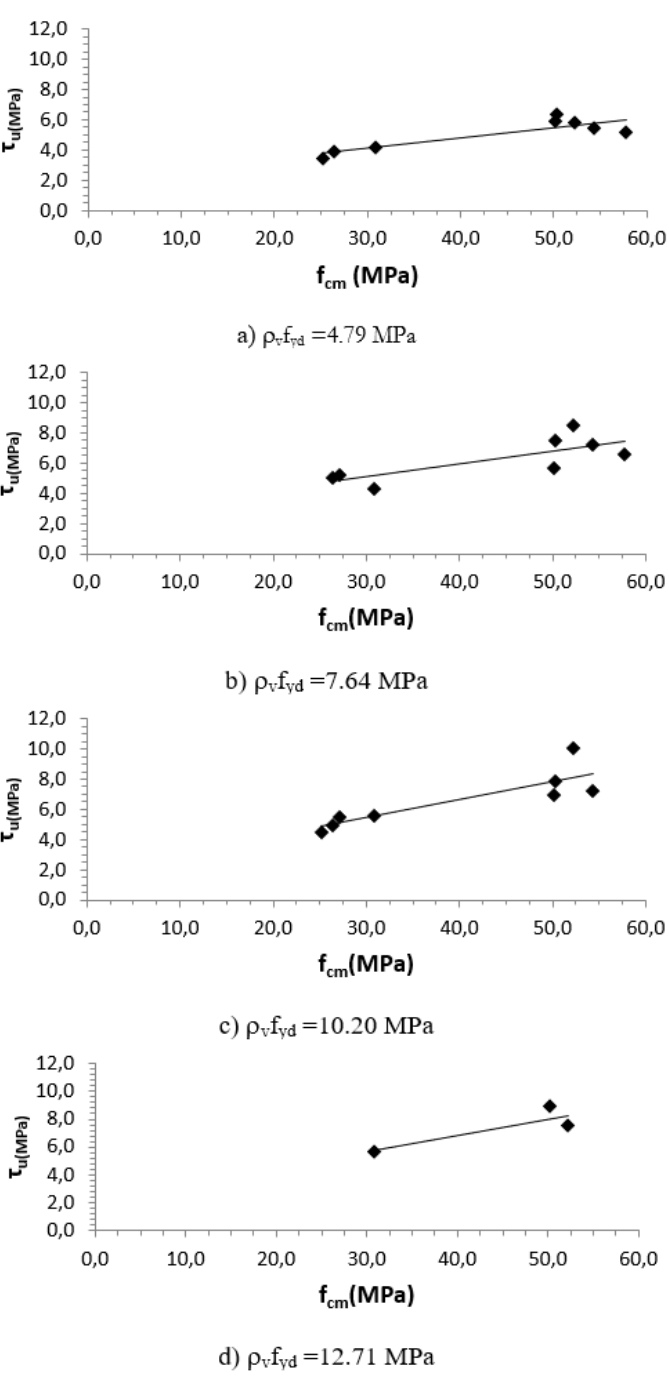
Figure 12. Influence of concrete compressive strength on the ultimate shear capacity for different clamping